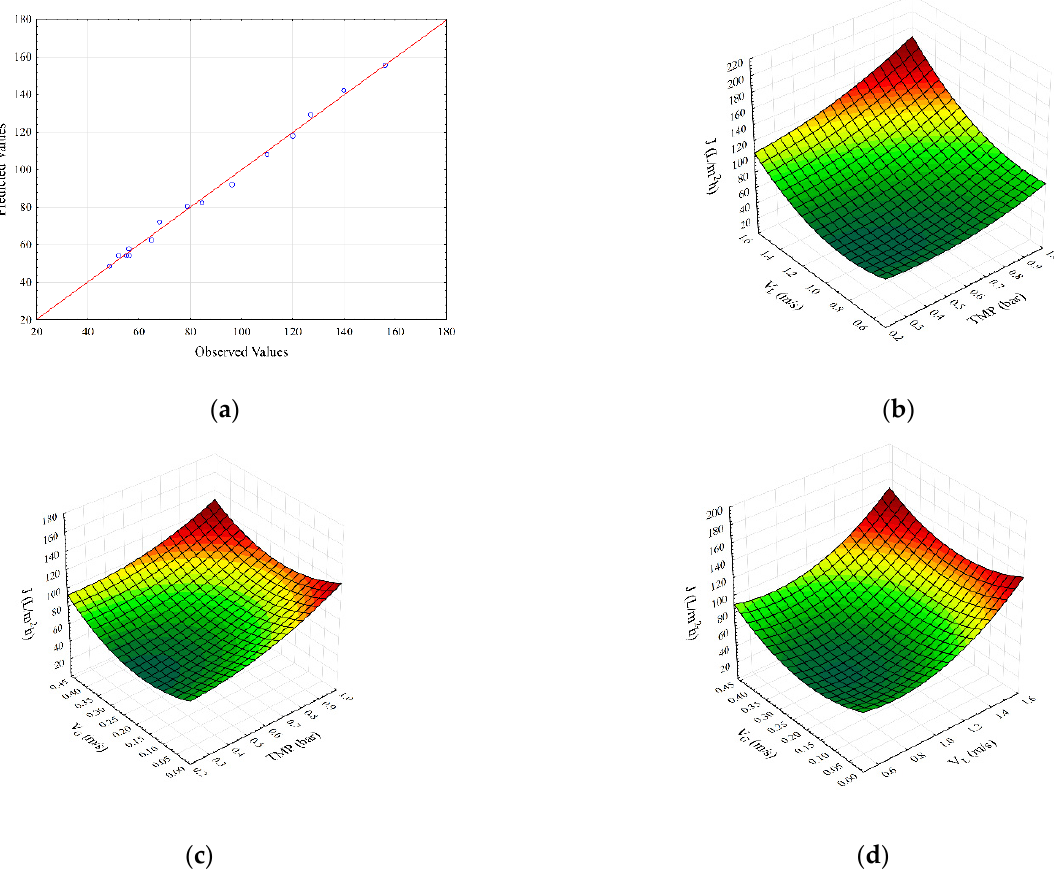
Figure 1. Parity plot ( a ) and response surface plots ( b – d ) representing the regression model for steady-state permeate flux during SMGS microfiltration of Bacillus velezensis IP22 cultivation broth.